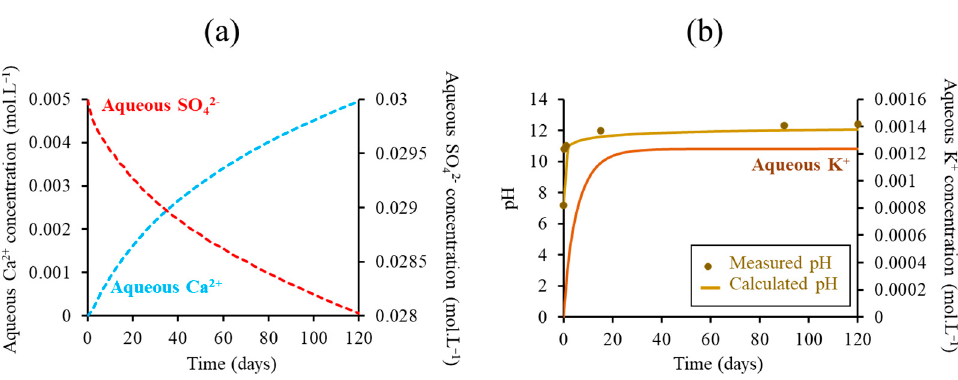
Figure 5. Calculation of the evolution over time of Ca 2+ , SO 42 − ( a ) and K + total concentrations and pH ( b ) in the tank solution. The pH is compared with the measured values.